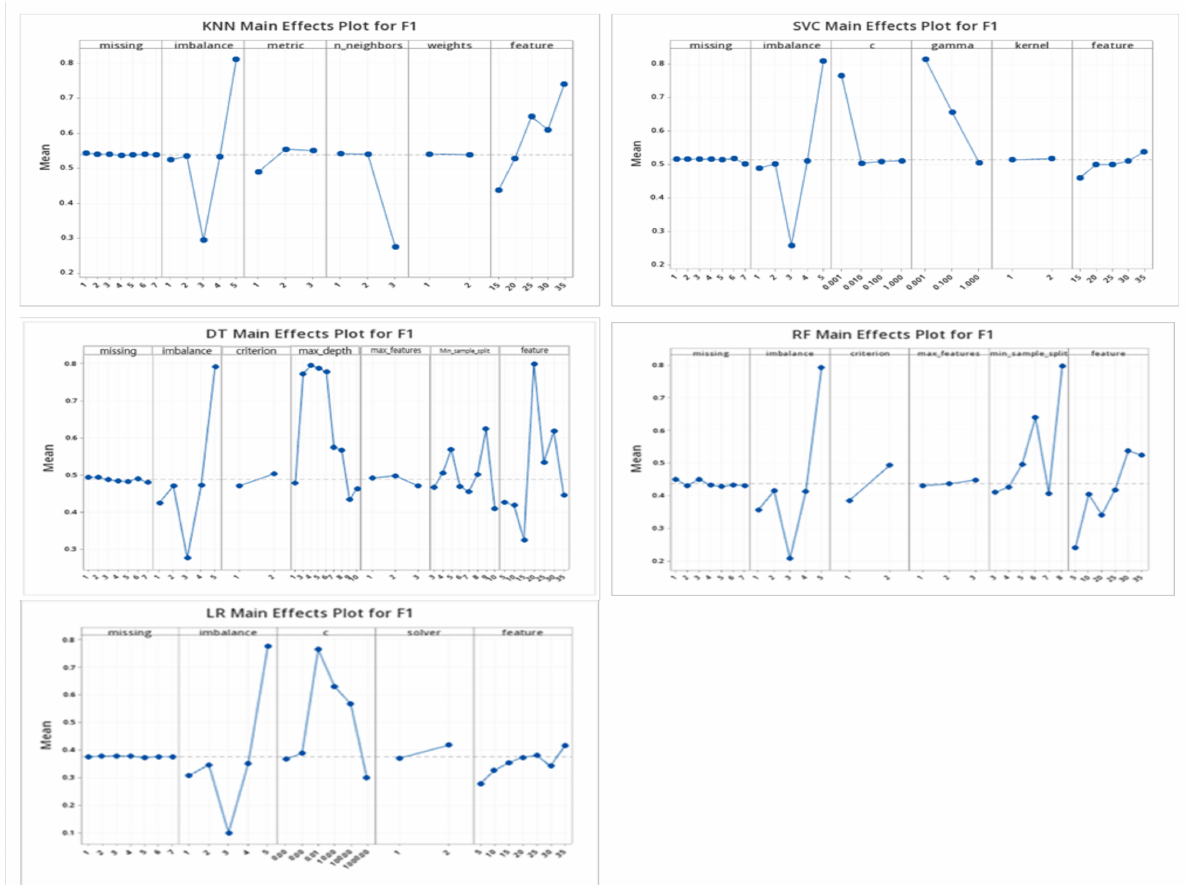
Figure 5. F1 scores for each of the